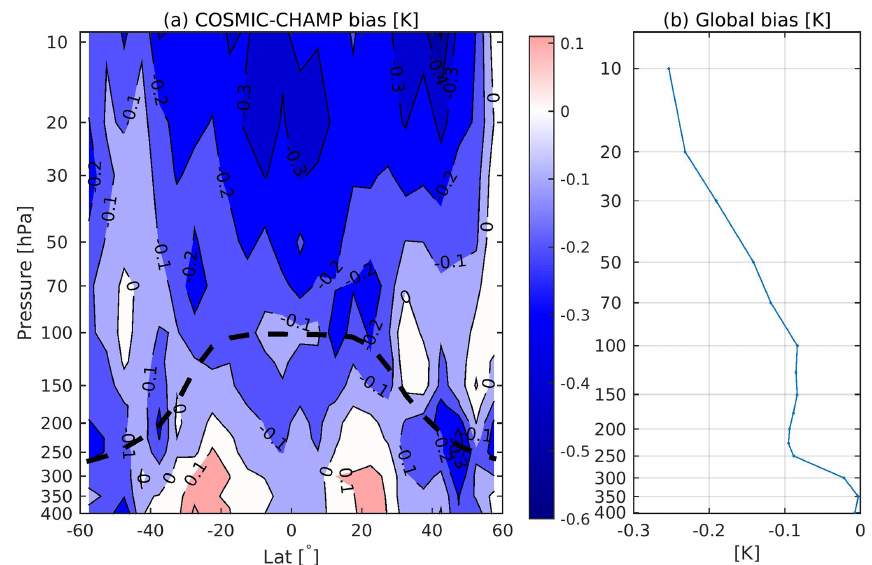
Figure 4. The bias in temperature climatology as retrieved from CHAMP and COSMIC RO data. The two missions obtained data during a 28-month overlap period from June 2006 to September 2008. (a) The difference of monthly zonal mean temperature. (b) The corresponding averaged difference for each layer. The dashed black lines mark the tropopause height calculated with GNSS RO data.